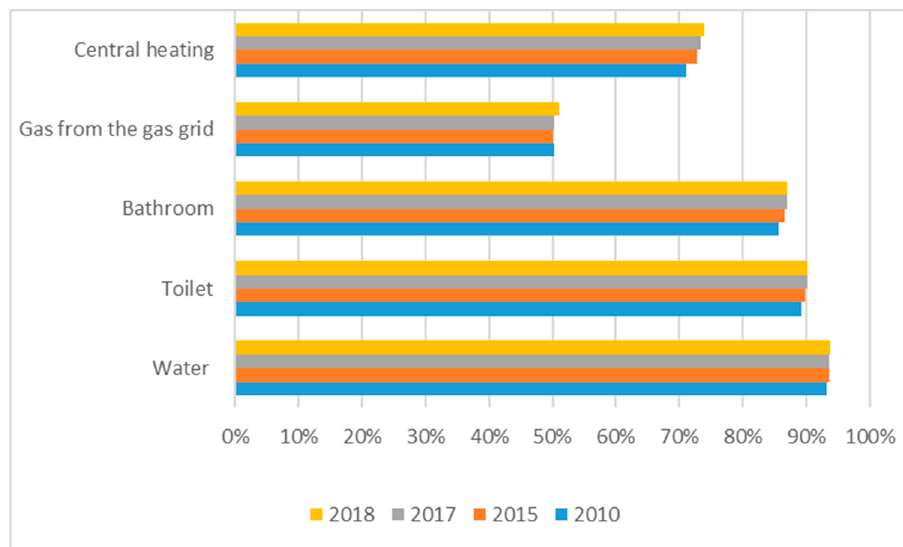
Figure 4. Population using the water main, the sewerage system, and the gas grid in rural communes of the Małopolskie Voivodeship from 2010 to 2018(%). Source: drawn by authors based on data from Poland statistic office [56].